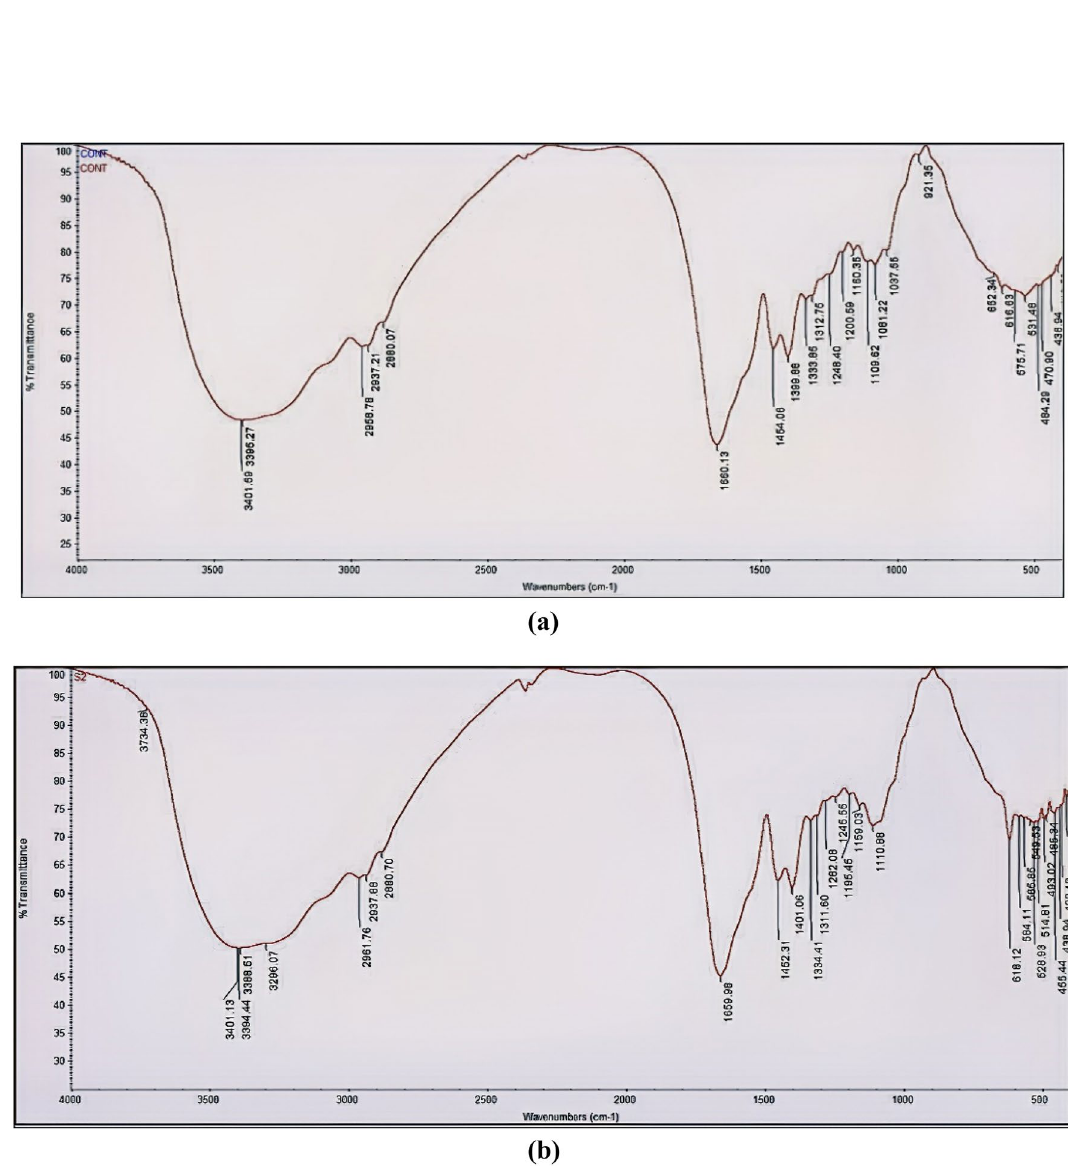
Figure 9. Fourier transform infrared (FTIR) spectra of ( a ) Aspergillus flavipes MN956655.1culture filtrate, ( b ) iron nanoparticles synthesized by Aspergillus flavipes